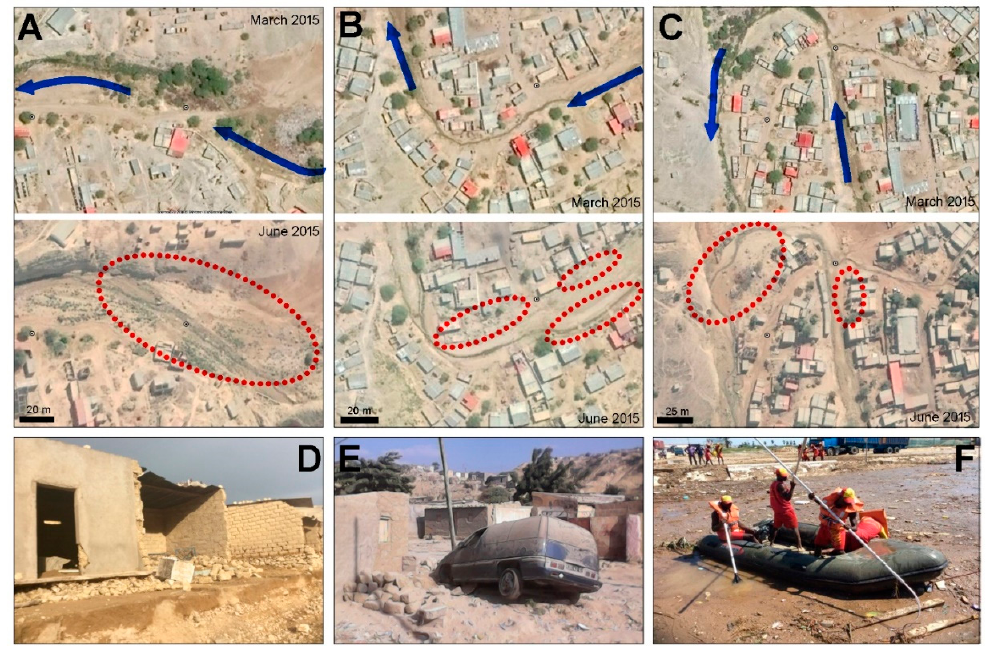
Figure 5. Images illustrating the effects of the 2015 floods. ( A – C ) Urban landscape changes due to the flash flood in a recently occupied area; arrows in upper panels indicate flow direction and the ellipses in the lower panel indicate areas with unrooted trees and collapsed houses. ( D ) Houses partially destroyed during the flood. ( E ) A car dragged by the current against a collapsed house. ( F ) Firefighters in the artificial drainage channel plugged with sediment and house-hold debris looking for flood victims. Satellite images from Google Earth™.